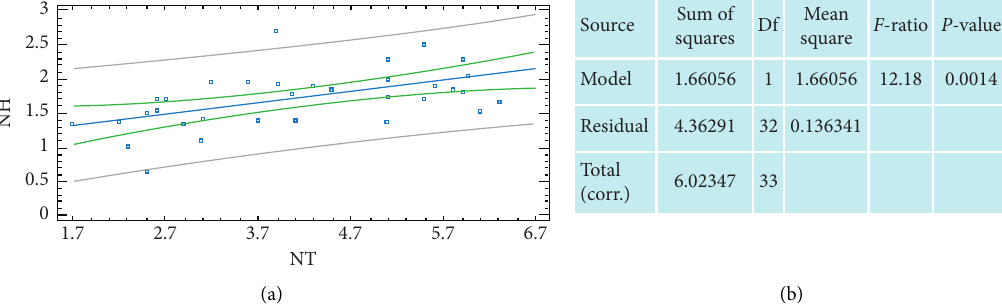
Figure 3: Linear model to describe the relationship between nest height above the ground (NH) and height of the supporting tree (NT).